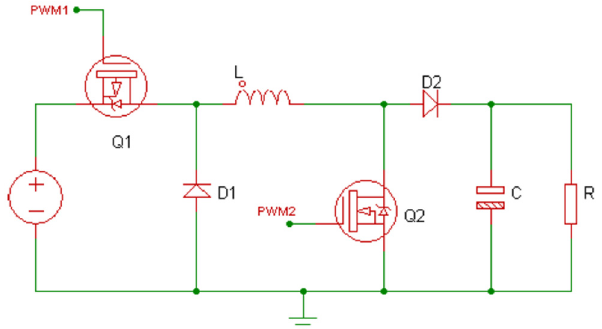
Figure 1. Topology of the buck-boost converter.